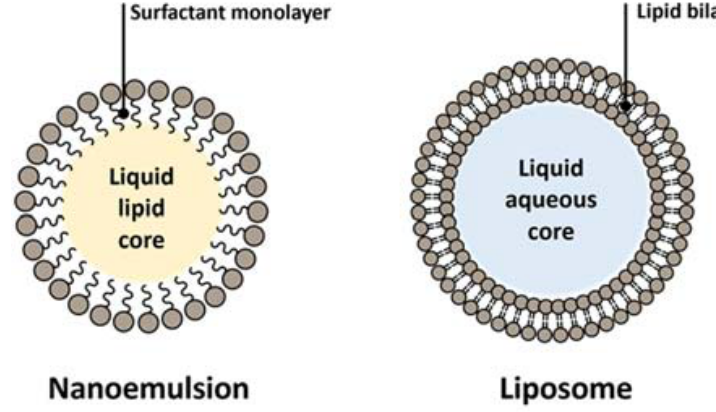
Figure 4. General representation of nanoemulsion and liposome.